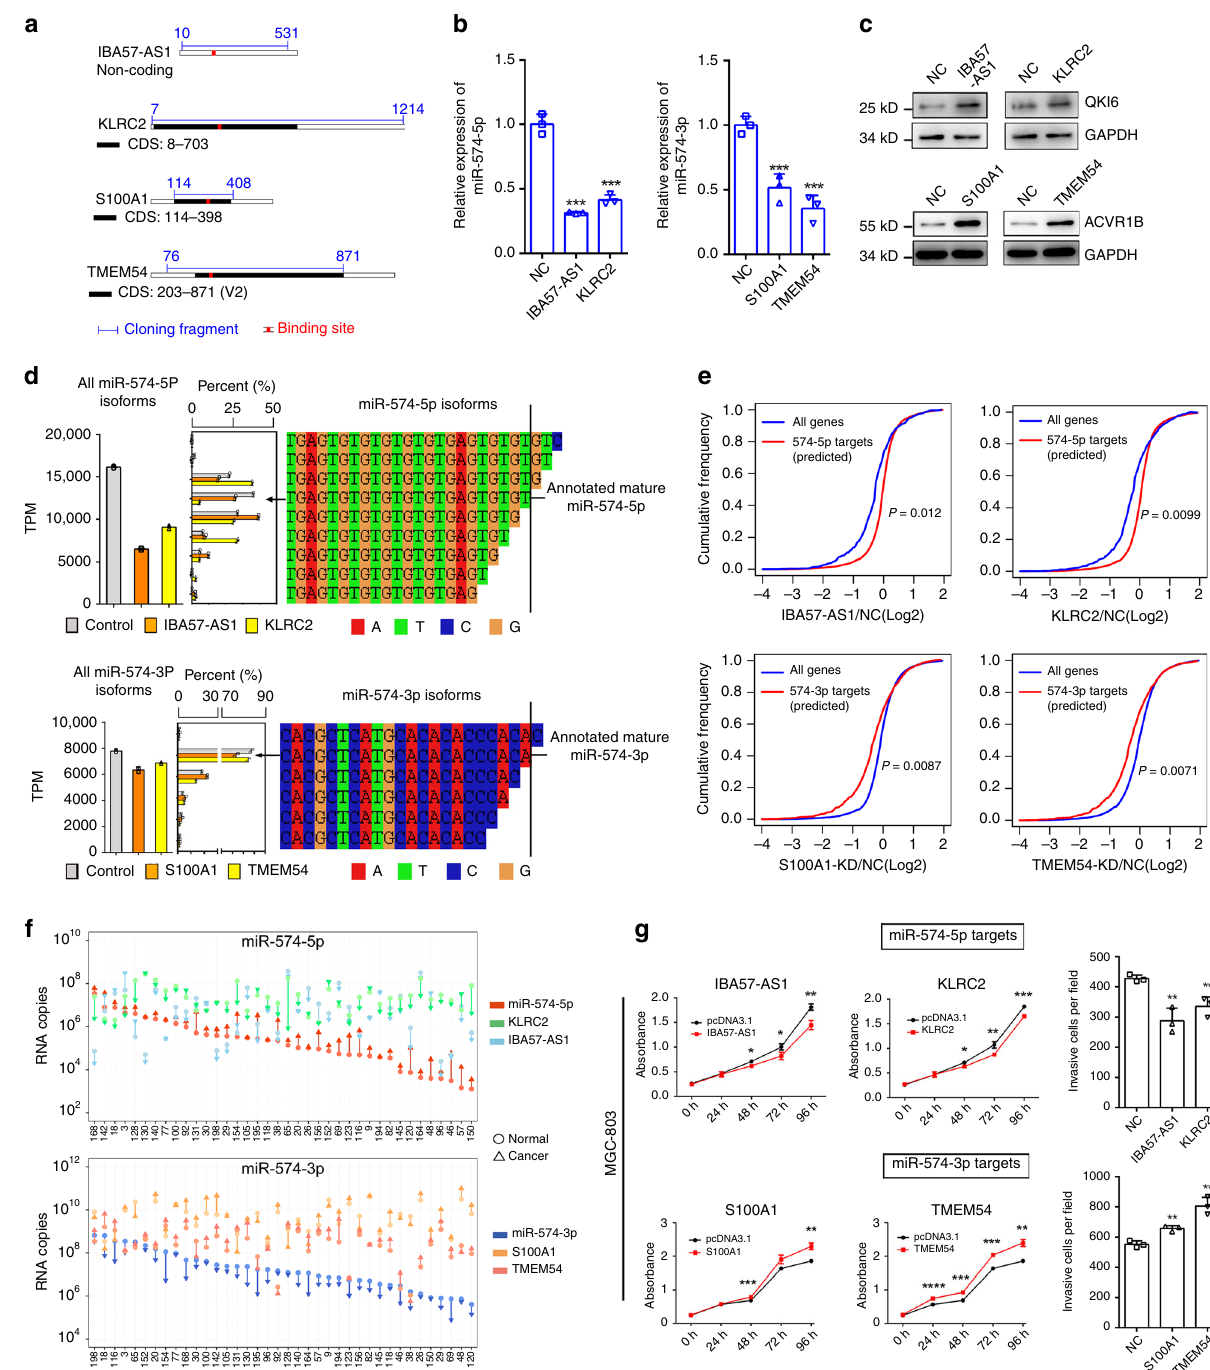
Fig. 5 miR-574-5p/-3p highly complementary targets can induce miRNA decrease. a Schematic representation of the four targets, including the miR-574 binding sites and cloning fragment for overexpression. CDS, coding sequence. b Relative expression of miR-574-5p/-3p in GC cells with overexpression of IBA57-AS1, KLRC2 or S100A1, TMEM54. c The protein level of QKI6 or ACVR1B in GC cells with overexpression of IBA57-AS1, KLRC2 or S100A1, TMEM54. d Left panel: Bar plot indicating the absolute miRNA expression levels in MGC-803 cells with overexpression of the targets. Middle panel: the proportion of different miRNA isoforms. Right panel: isoform sequences displayed by color-coding. e Global expression of the potential miR-574 targets in MGC-803 cells with IBA57-AS1, KLRC2 overexpression and S100A1, TMEM54 knock down, respectively. f The absolute RNA copy number of the four targets (IBA57-AS1, KLRC2, S100A1, and TMEM54) and miR-574-5p/-3p in gastric cancer patients with previously identi fi ed inversely differential expression of miR-574-5p/-3p. g The proliferation rate (left) and invasion ability (right) of MGC-803 cells with overexpression of IBA57-AS1, KLRC2, S100A1, and TMEM54. Three technical replicates from a single experiment representative of two or three independent experiments. Data are shown as means ± s.d. * p < 0.05, ** p < 0.01, *** p < 0.001, Student ’ s t -test.